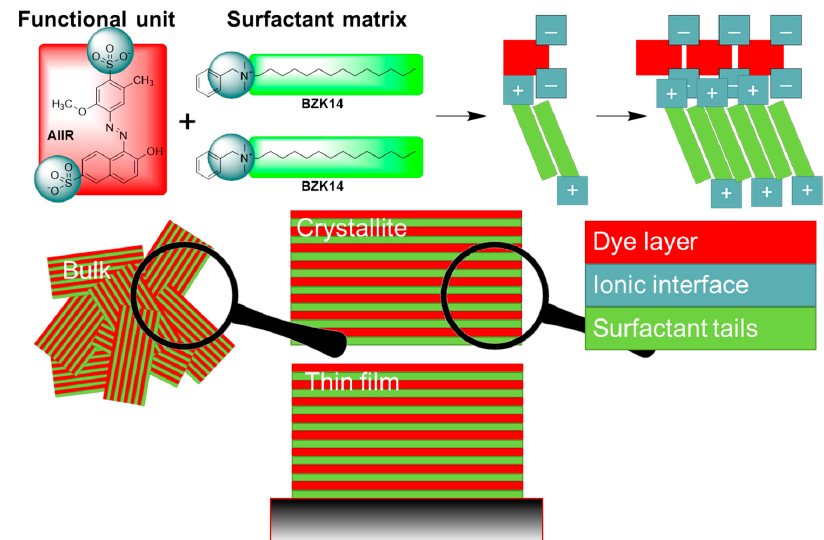
Figure 2. Cartoon representing the synthesis and the molecular structure of the homolog ionic self-assembled materials based on Allura Red, Bordeaux red, Amaranth and Trypan Blue anionic azo-dyes and cationic benzalkonium surfactants with alkane tail of varying length. The lamellar structure is randomly organized in bulk, but oriented in thin films. The lamellar may be divided in three sections, a dye layer (red), an ionic interface (gray), and spacing layer of alkyl chains (green). The systems studied here are identical, except the length of the alkyl chains of the surfactant used, which is assumed to give rise to a systematic increase in layer separation.